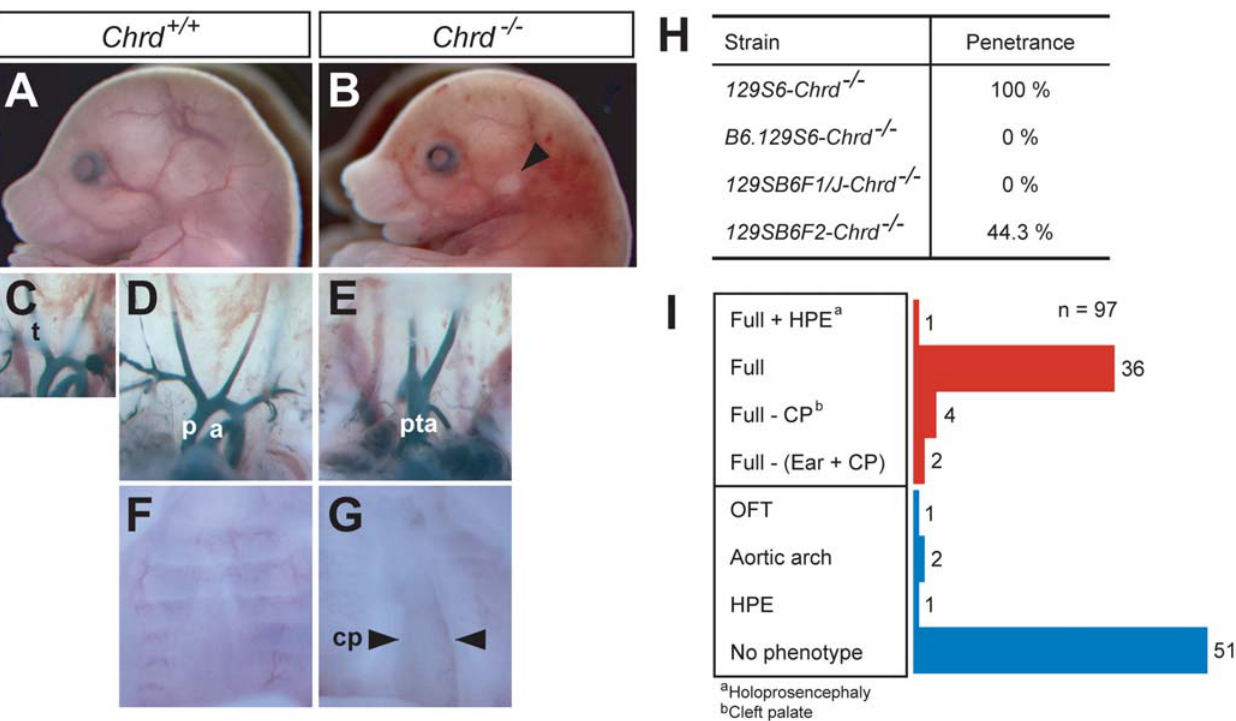
Figure 1. Phenotype of Chrd mutant embryos in 129S6 inbred and hybrid backgrounds. (A–G) Comparison of organ structures in wildtype and Chrd mutant embryos at embryonic day (E) 15.5. Ears of Chrd 2 / 2 embryos are abnormally located and fail to form auricle structures (A, B). Athymia, persistent truncus arteriosus (PTA; failure of outflow tract septation) and abnormal aortic arch artery structure are observed in the mutant (C–E). Cleft palate (CP) is also a feature of the mutant embryos (F, G). (H) Penetrance of Chrd null mutation in various genetic backgrounds; it shows complete penetrance in the 129S6 strain and partial penetrance in the F2 hybrid (129SB6F2) strain. (I) Phenotypic pattern of 129SB6F2- Chrd 2 / 2 embryos. The majority of embryos showed either a ‘Full phenotype’ (as defined in the main text) or no phenotype. Several embryos (11/97) showed variable DGS-like phenotypes. Despite this variability, the embryos can be classified into two groups: those that retain DGS-like phenotypes (in red), and those devoid of DGS-like phenotypes (in blue). a, aorta; cp, cleft palate; HPE, holoprosencephaly; p, pulmonary trunk; pta, persistent truncus arteriosus; t, thymus.